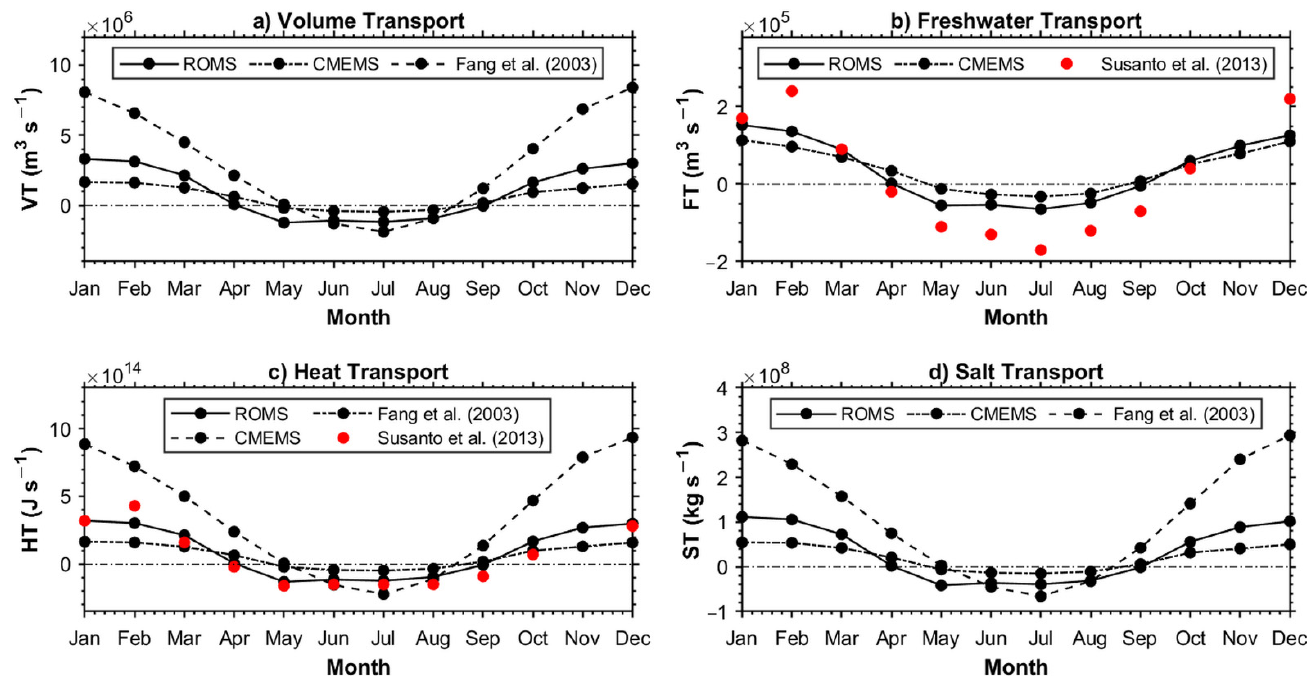
Figure 8. Seasonal variability of ( a ) volume (unit: m 3 s − 1 ), ( b ) freshwater (unit: m 3 s − 1 ), ( c ) heat (unit: J s − 1 ), and ( d ) salt (unit: kg s − 1 ) transports derived from ROMS (solid line), CMEMS (dashed-dot line), Fang et al. [25] (dashed-line), and Susanto et al. [22] (red circles). Positive values denote the outflow from the SSCS though the Karimata Strait into the JS, while negative values denote the inflow from the JS through the Karimata Strait into the SSCS.